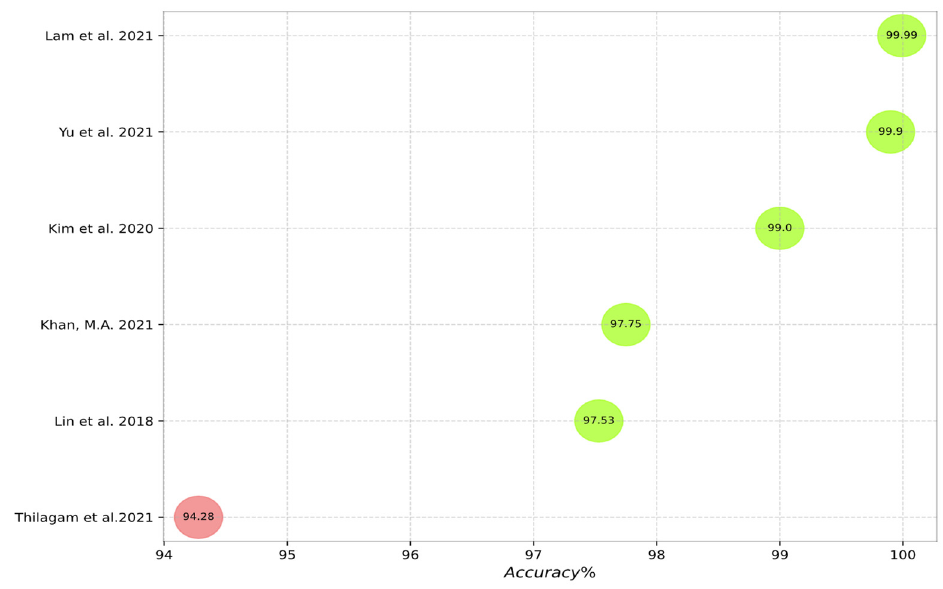
Figure 14. Accuracy of the studied schemes on the CSE-CIC-IDS2018 dataset [21,23,27,51,54,66].